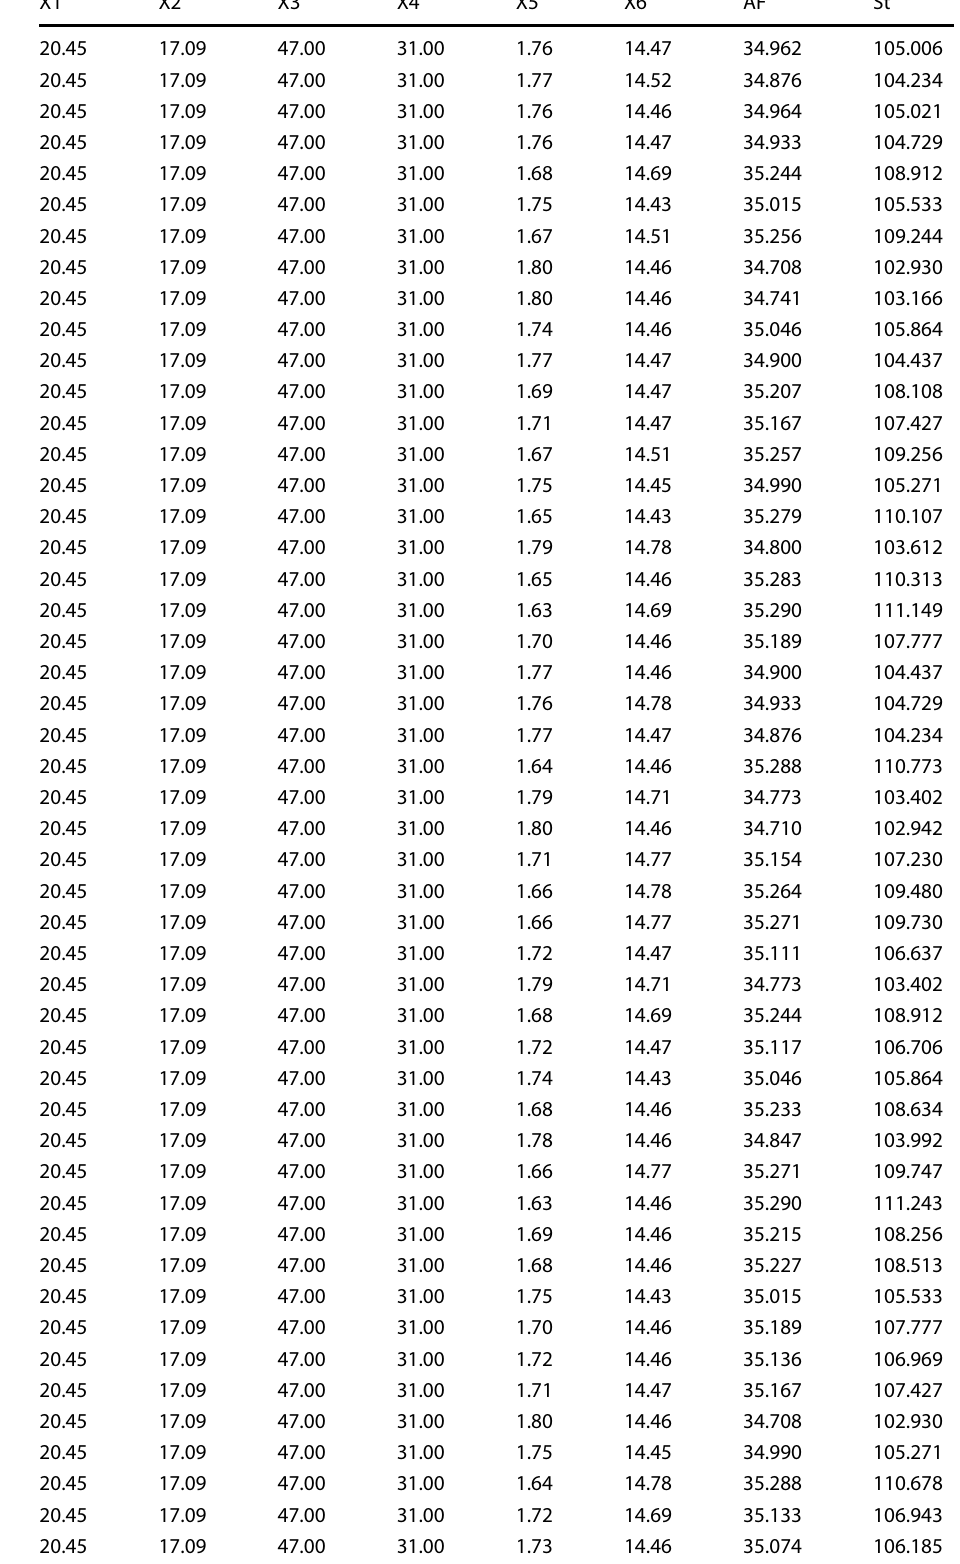
Table 13 Points of optimal